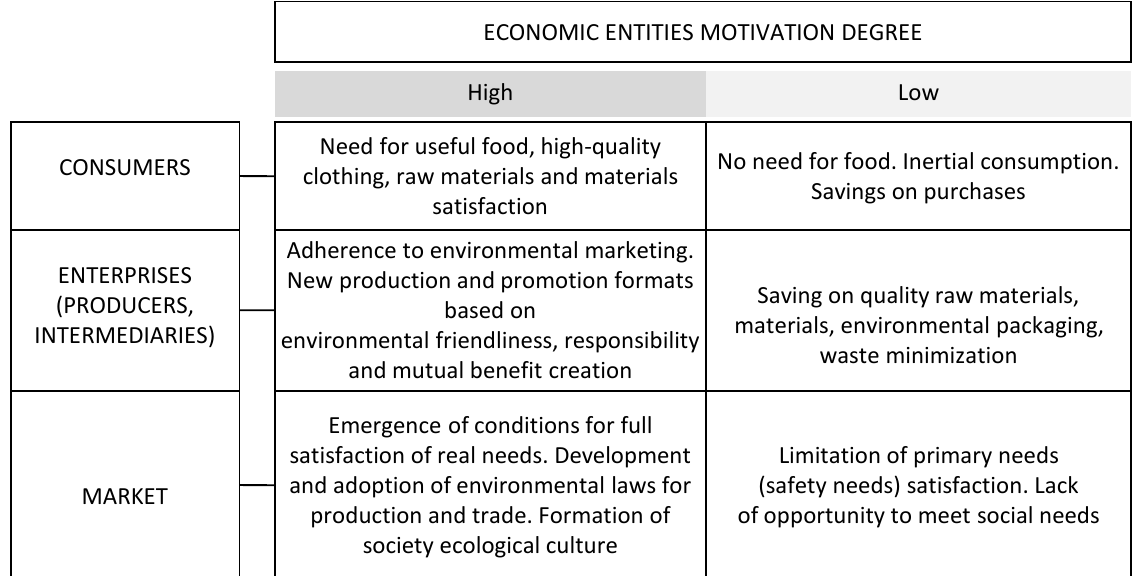
Figure 4. Environmentally-oriented consumer behavior: the degree of motivation